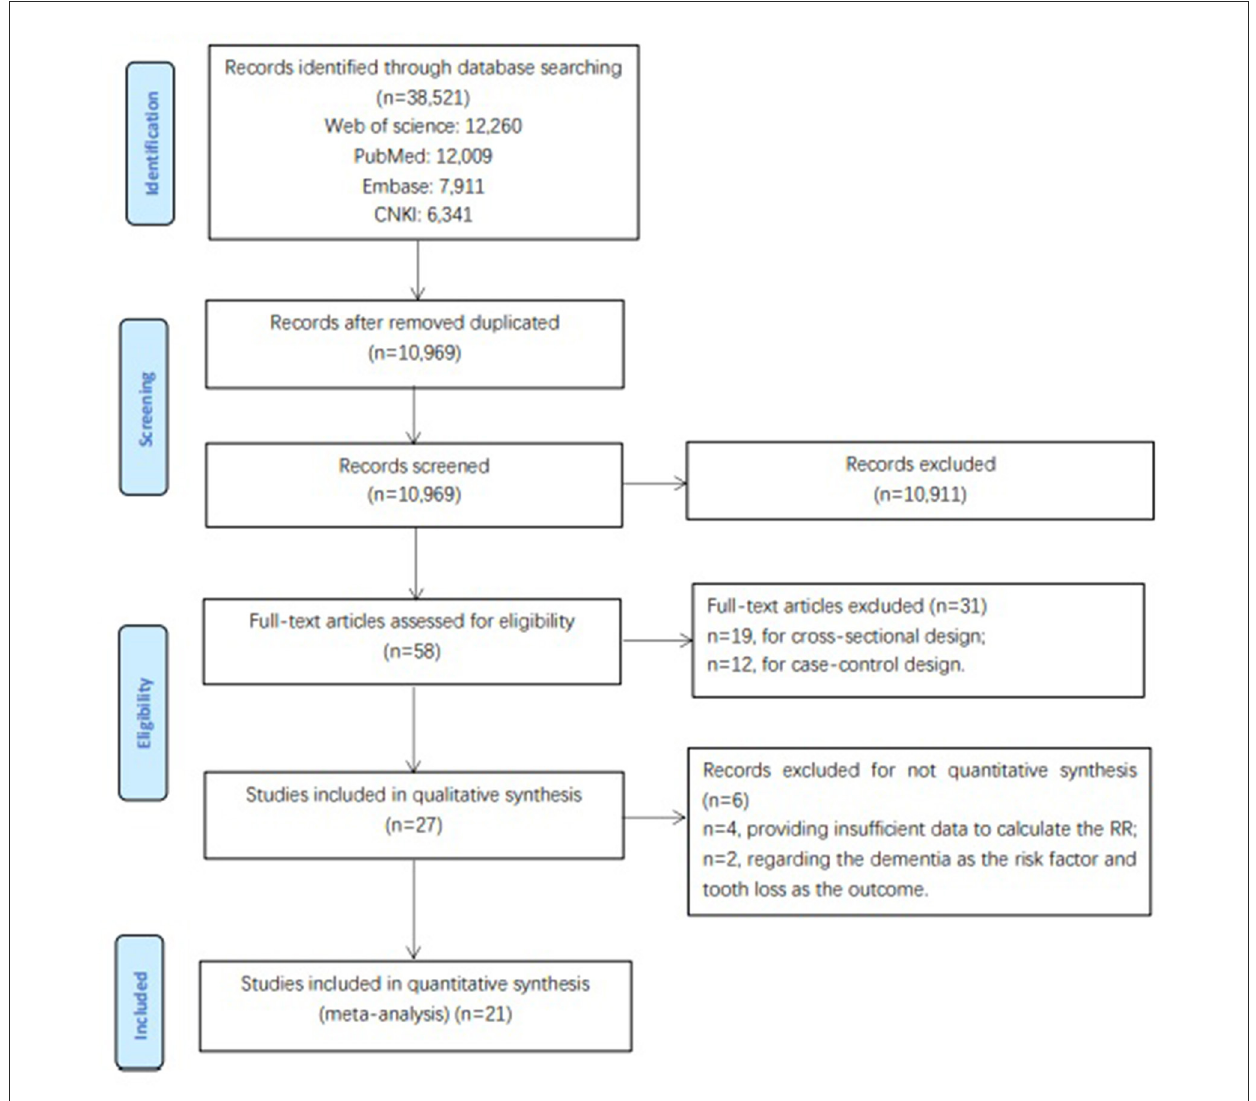
FIGURE1 Flow chart of study